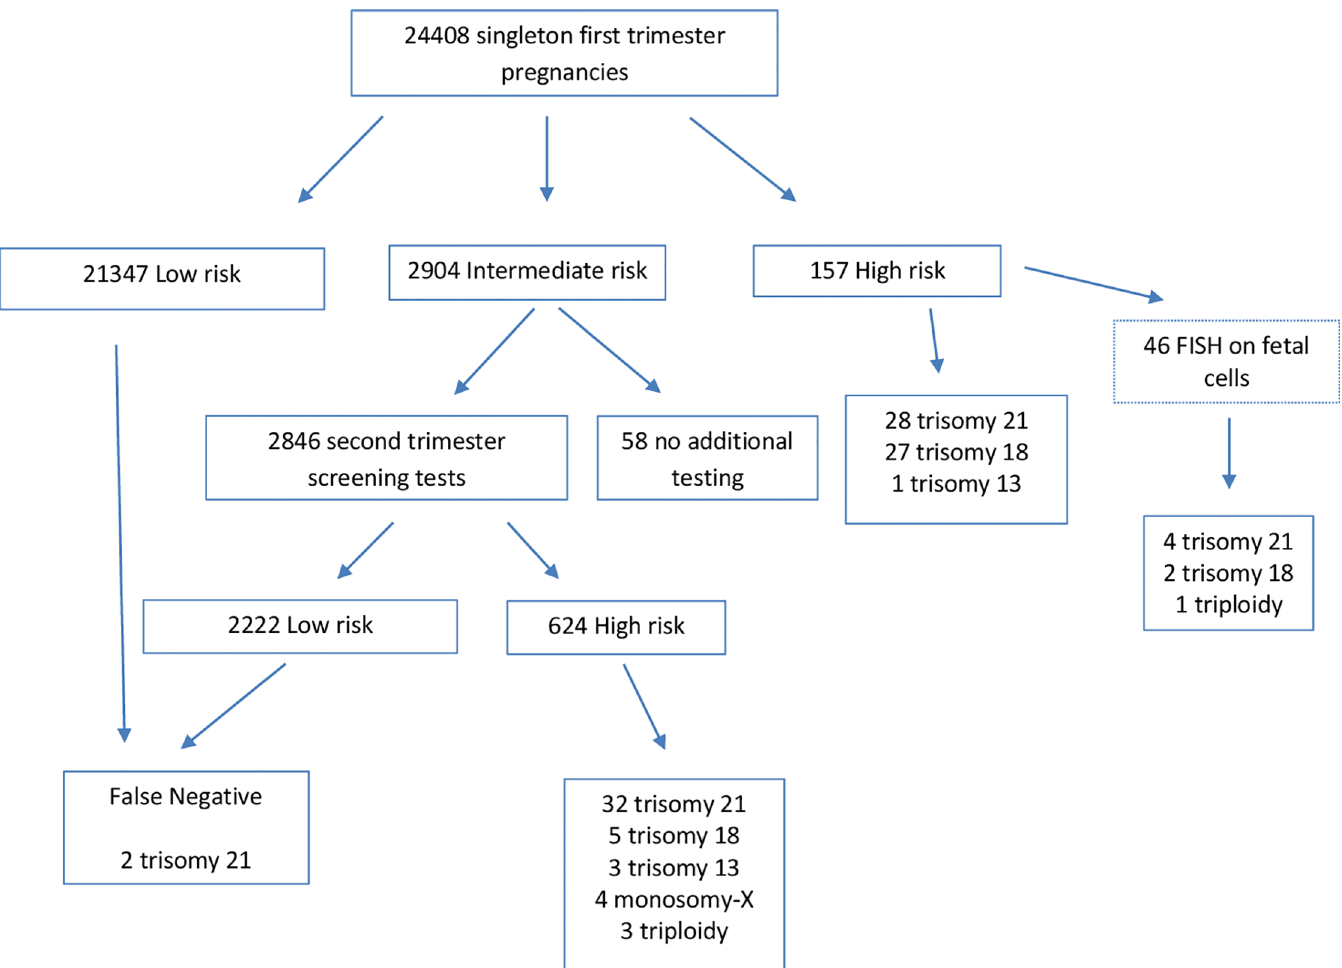
Fig 1. Flow diagram of cases included in the sequential